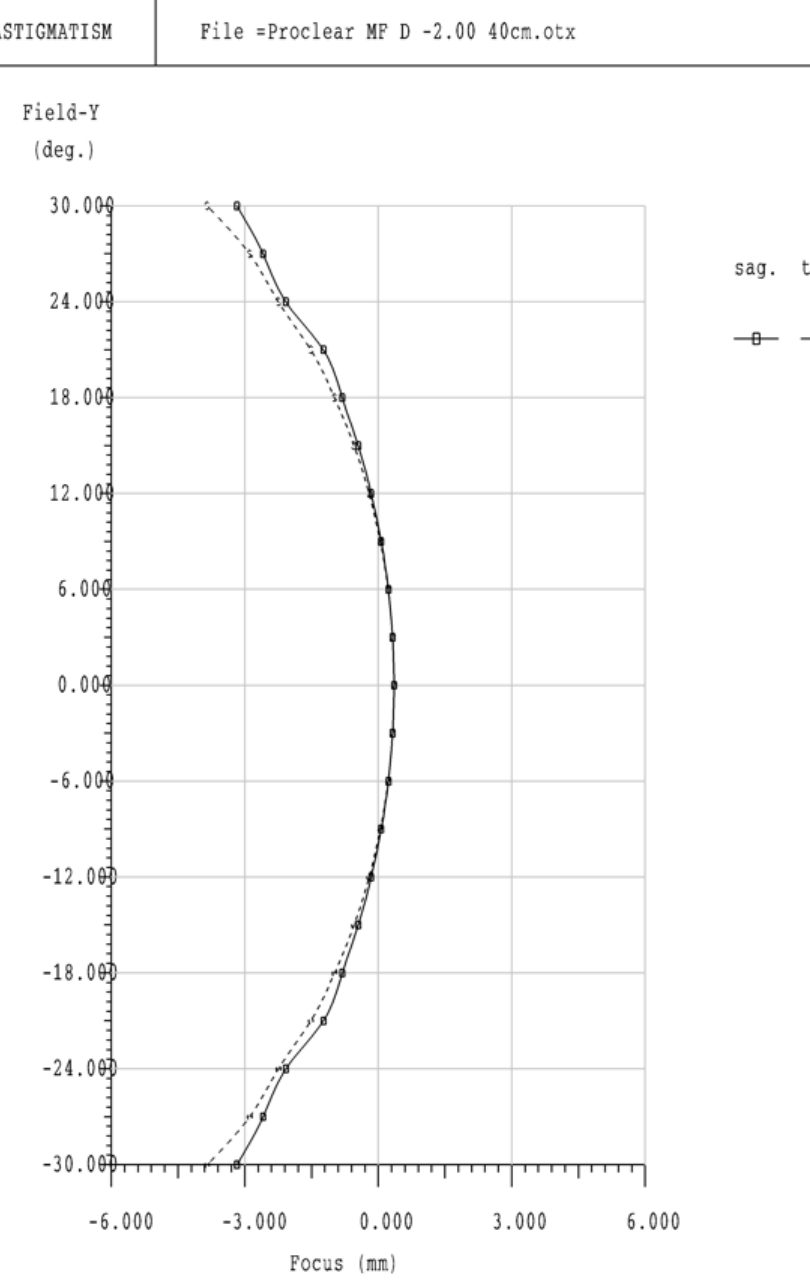
Figure 8. Peripheral refraction with Proclear multifocal correction − 2.00 D of myopia, viewing distance at 40 cm: sagittal and tangential focal lines. Within the central 18 ◦ a lag of accommodation is visible that refers to a hyperopic defocus. Outside the central 18 ◦ both focal lines become myopic relative to the center (Fovea).